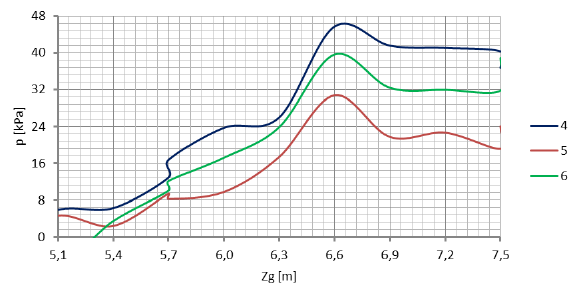
Figure 8: Plots of normal interactions along perimeter zone of